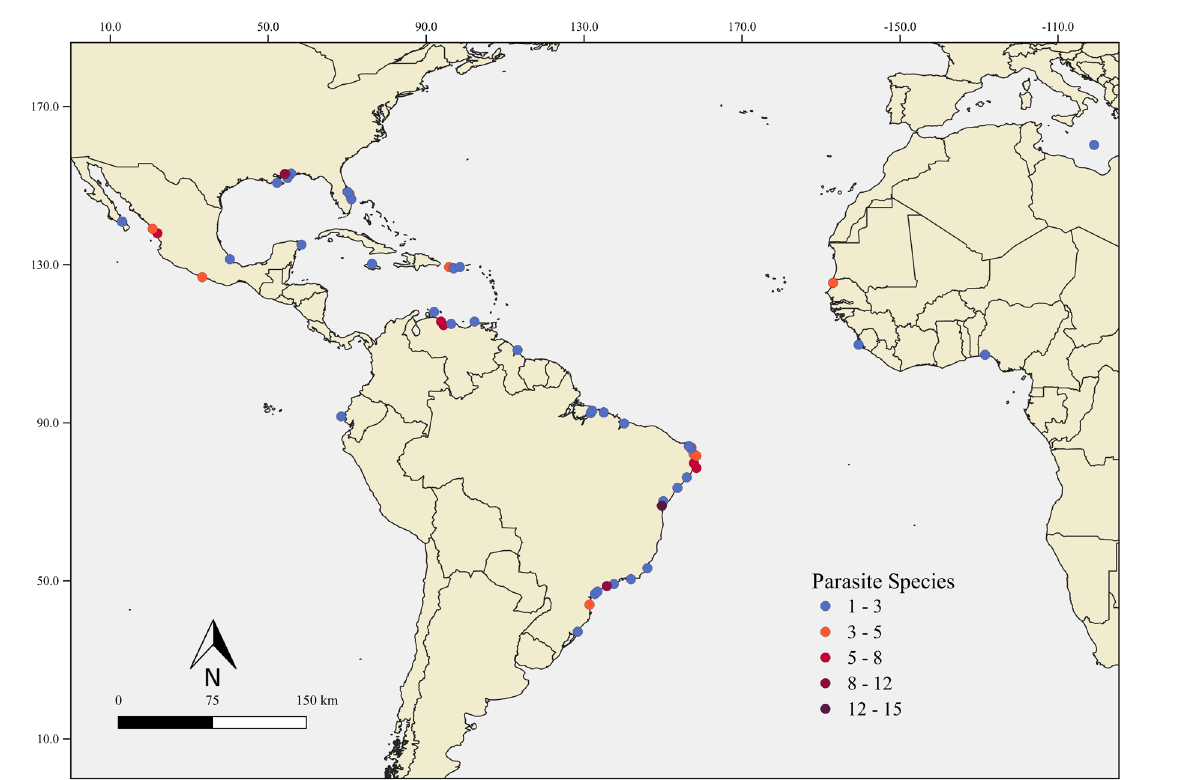
Figure 3. Localities with parasite records associated with the host M. curema , by number of species per localities.